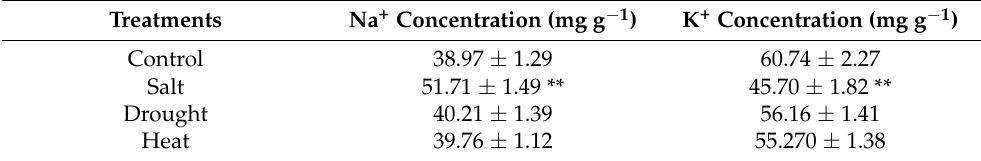
Table 3. Effect of salt, heat and drought stress on Na + and K +